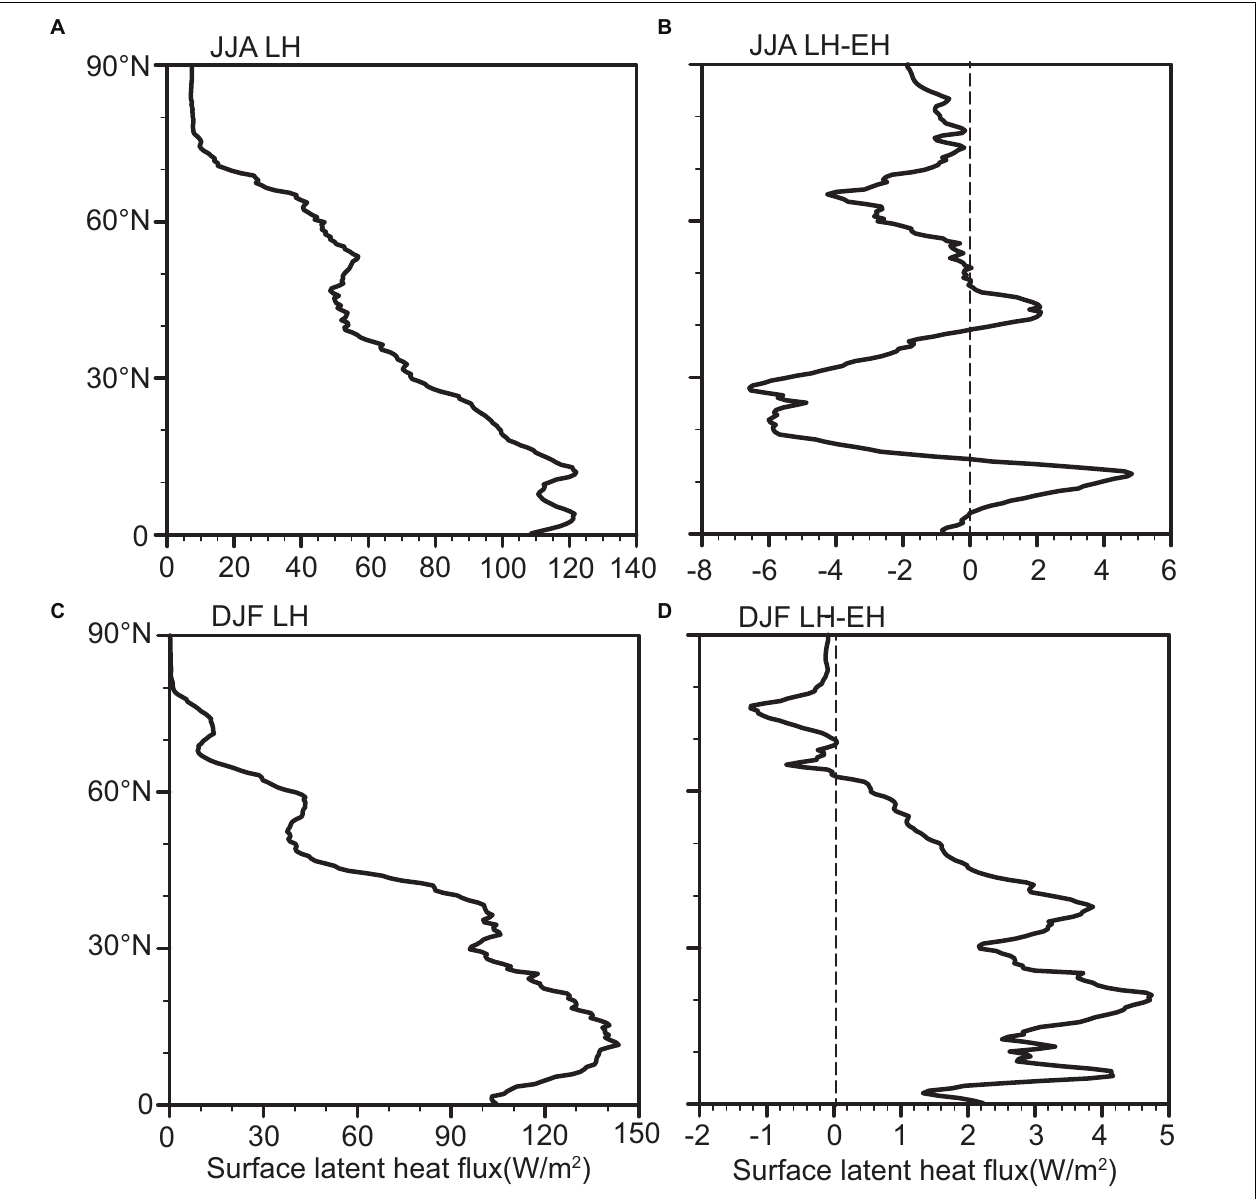
FIGURE 12 | Zonal mean surface latent heat flux. Summer and winter surface latent heat flux in LH (A,C) and the LH-minus-EH difference (B,D) .